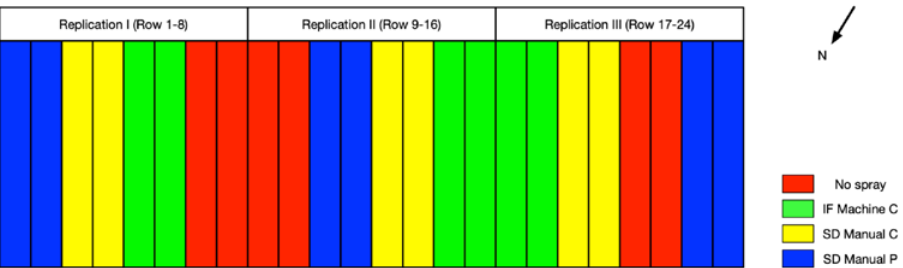
Figure 8. Plot design for testing the effectiveness of fungicide on plant-by-plant treatment. Note: IF Machine C = in-furrow machinery continuous spray, SD manual C = stem-drench manual continuous spray, and SD Manual P = stem-drench manual pulsed spray.